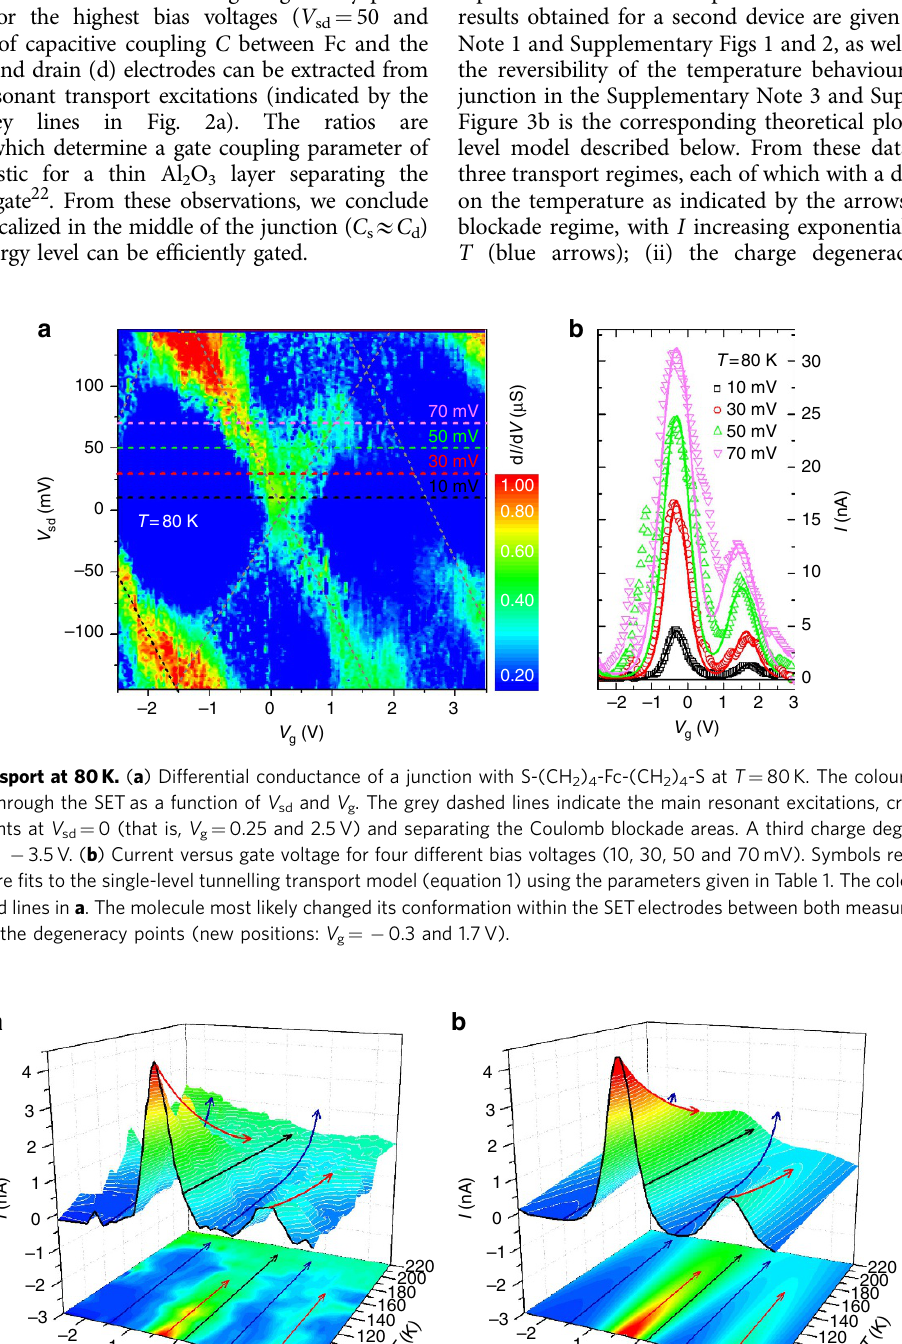
coded dashed lines in Fig. 2a (the solid lines are fits to the model 70mV). The ratios of capacitive coupling C between Fc and the gate (g), source (s) and drain (d) electrodes can be extracted from tilted, dashed grey lines in Fig. 2a). The ratios are